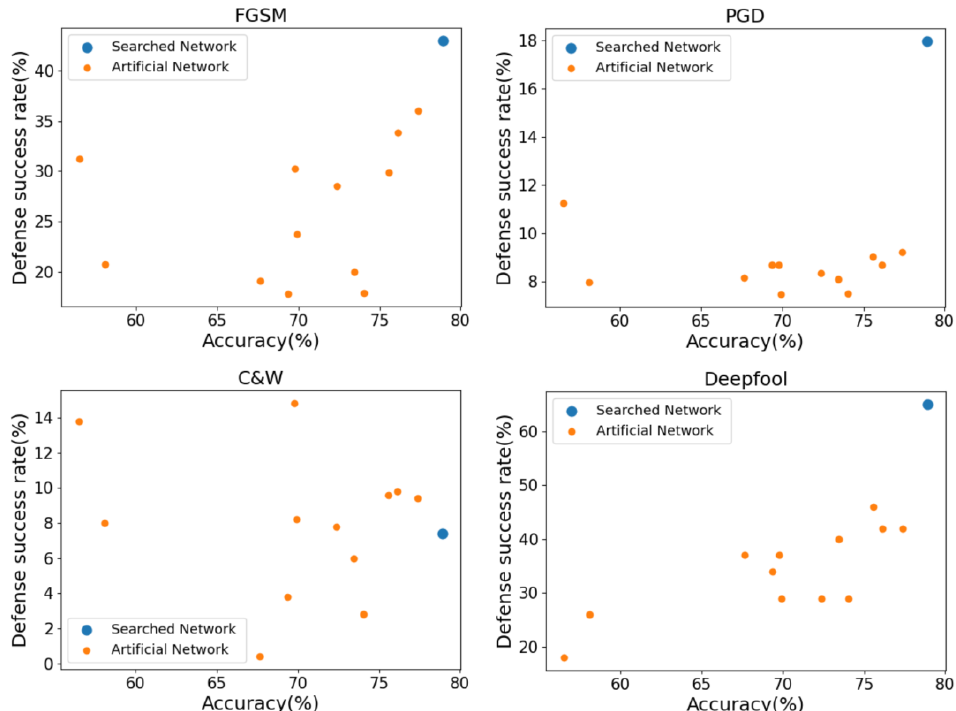
Figure 7. Comparison with artificially designed networks.